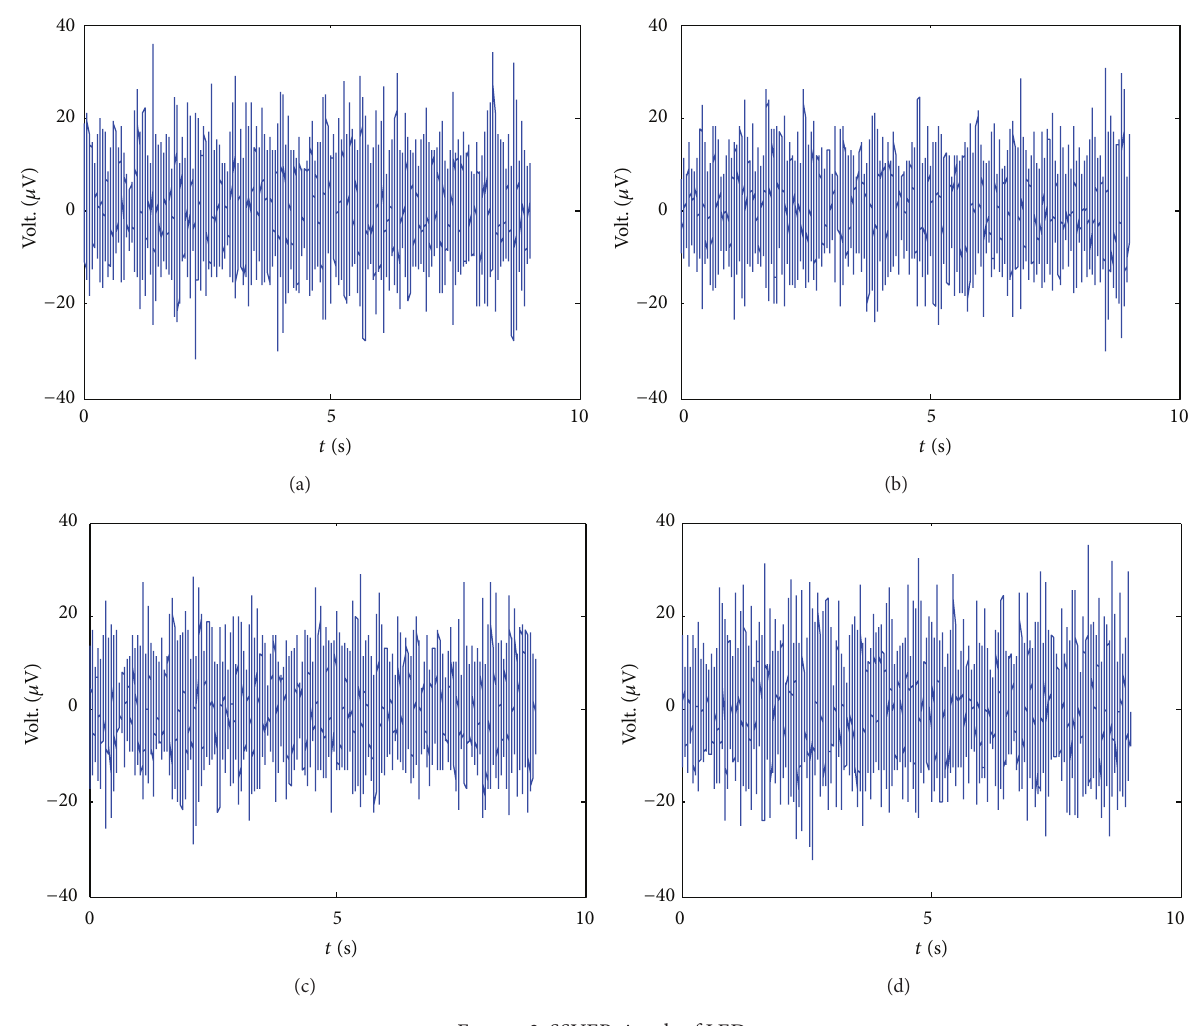
Figure 2: SSVEP signals of